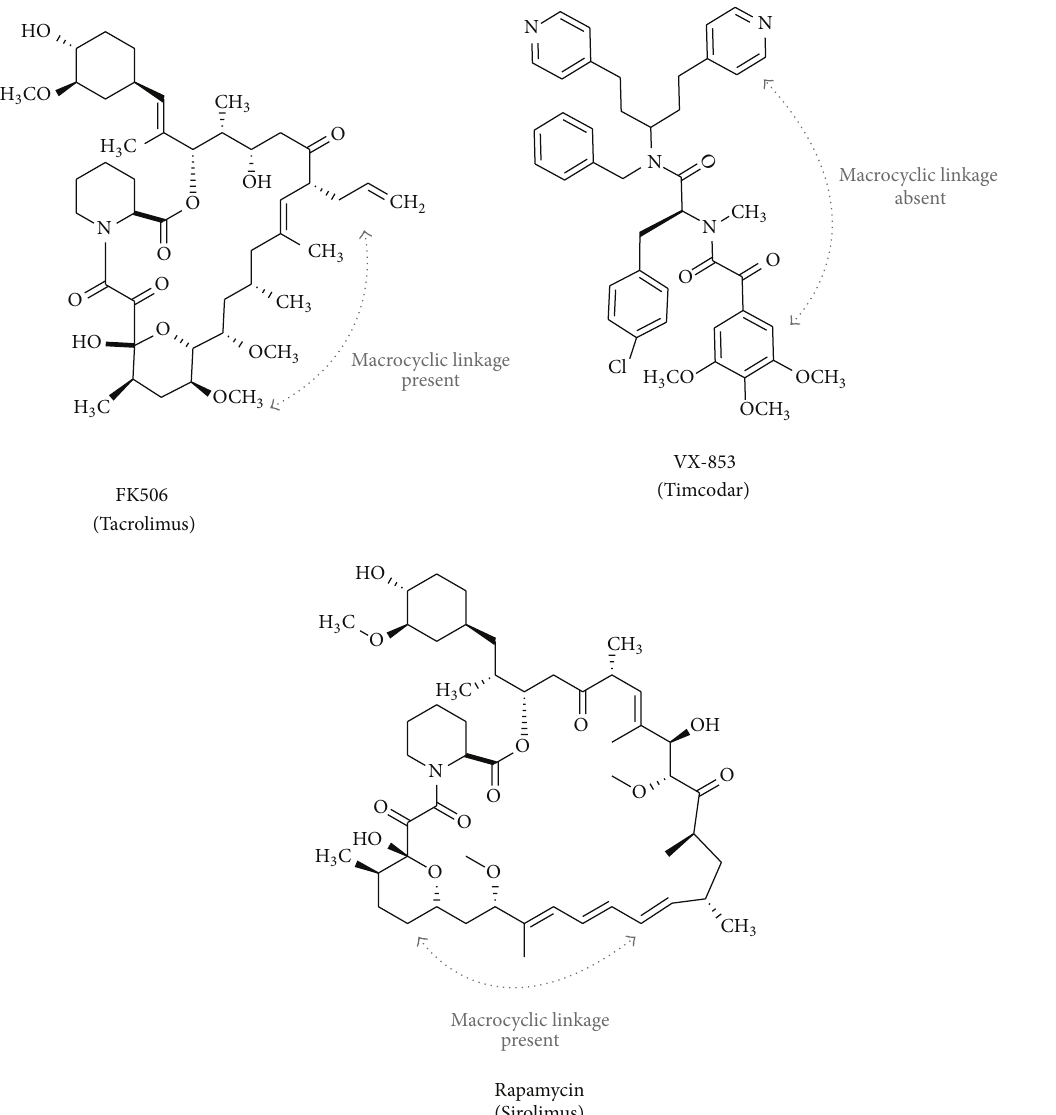
Figure 1: Structural comparison of FKBP binding macrolides and timcodar. Chemical structures of FK506 (Tacrolimus), timcodar (VX-853), and rapamycin (Sirolimus). Note that VX-853 is not a macrocycle (highlighted by the presence and absence of a “macrocyclic